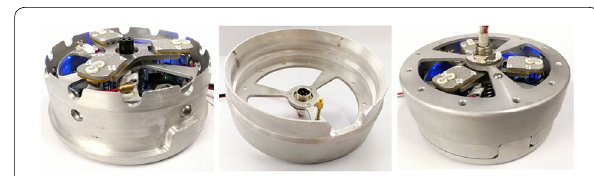
Figure 17 Prototype of the RCM based on SMA